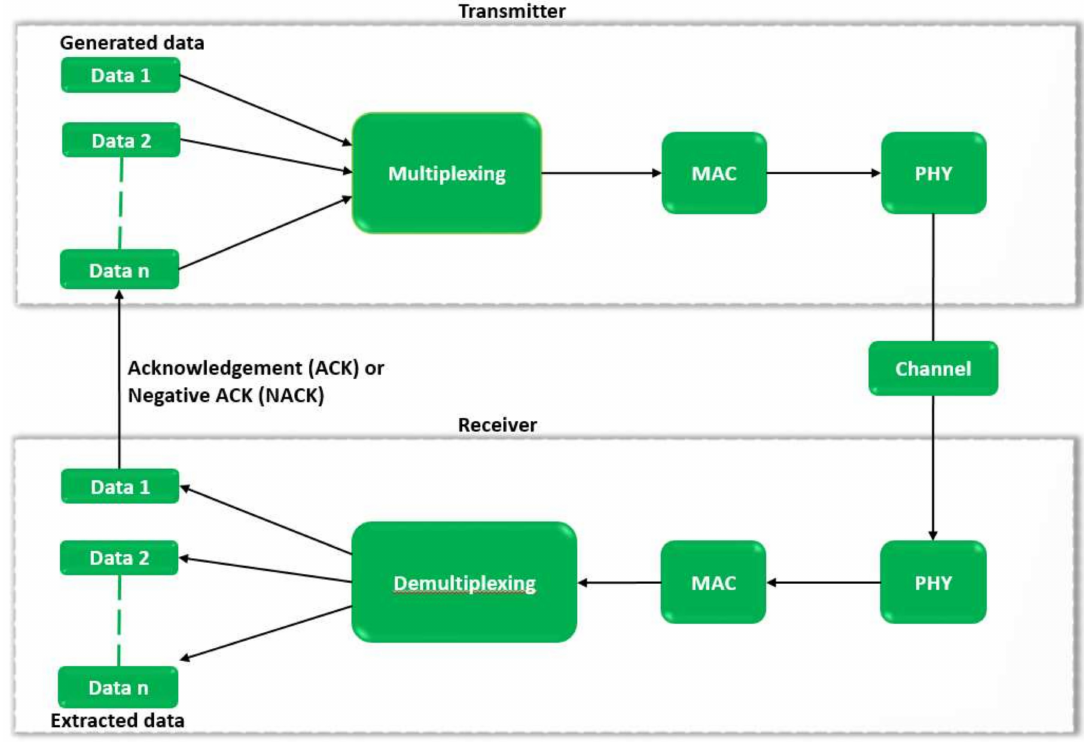
Figure 8. Block diagram for multiplexing